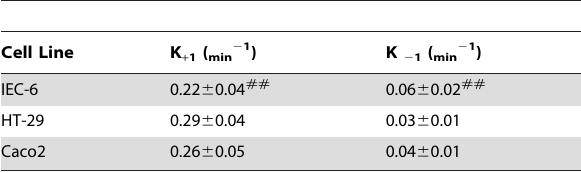
Table 3. Association rate constants and dissociation rate constants for ITF binding with epithelial cells (n=6).